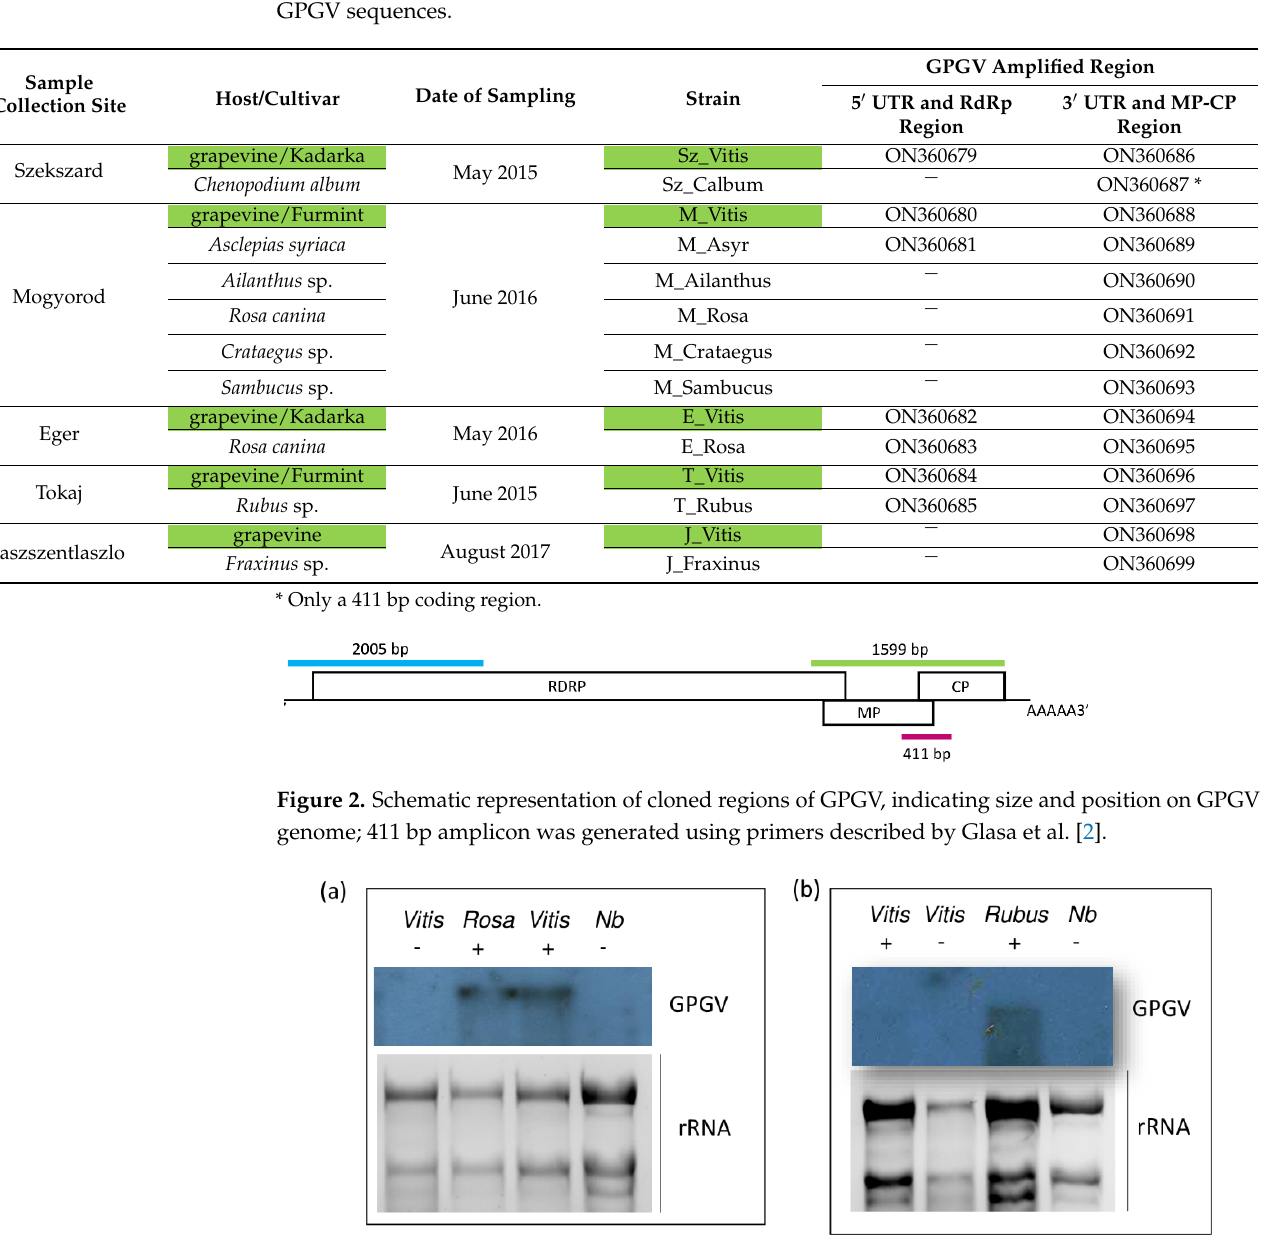
Table 1. Basic information of sampled plants and GenBank accession numbers of deposited GPGV sequences.